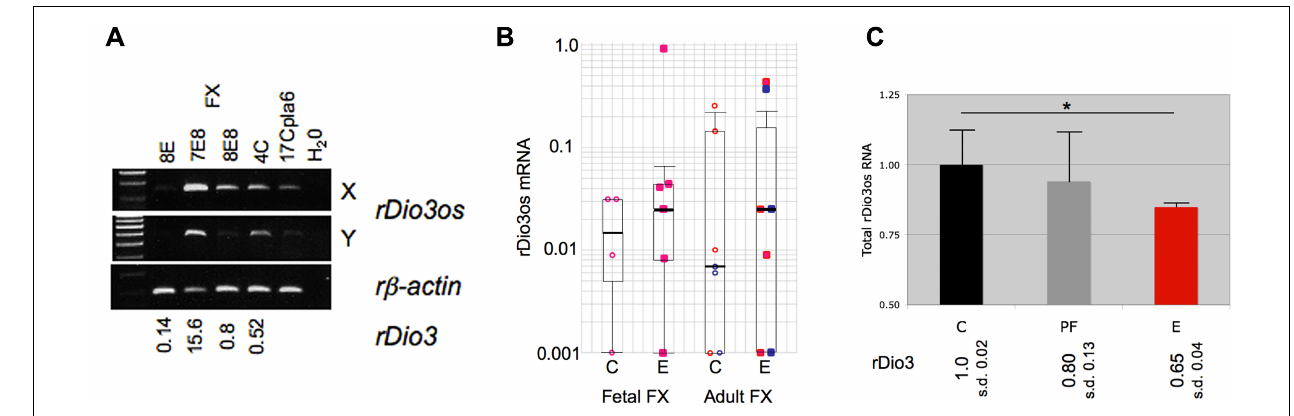
FIGURE 4 | Coordinate response of rDio3 and rDio3os to prenatal ethanol exposure. (A) Semi-quantitative RT-PCR from fetal frontal cortex of individual control (C) and ethanol-treated animals (E) demonstrates levels of rDio3os expression tracking total rDio3 expression (relative levels from qRT-PCR in triplicate, normalized to beta-actin; L.S.) for both unspliced (X) and potentially spliced (Y) transcript-specific primer pairs. All animals are from an S × B cross. A placental rDio3os sample shown for comparison. Note that 4C is an upper outlier from controls to allow visualization of expression product. (B) Semi-quantitative RT-PCR from female fetal or adult rat S × B frontal cortex (FC) from control (C) or prenatally